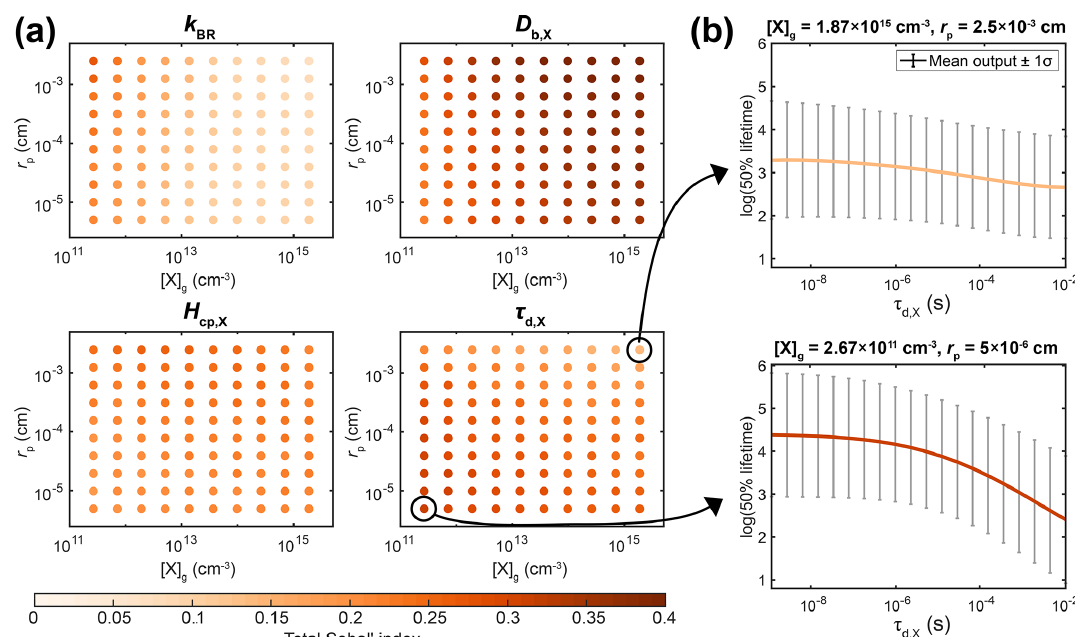
Figure 5. Detailed sensitivity analysis with the PCE method as a function of experimental conditions, i.e., the gas-phase concentration of X ([X] g,0 ) and particle radius ( r p ). (a) Total Sobol’ indices of four KM input parameters: bulk reaction rate coefficient of X and Y ( k BR ), bulk diffusion coefficient of X ( D b,X ), solubility coefficient of X ( H cp,X ), and desorption lifetime of X ( τ d,X ). (b) Relationship between the value of τ d,X and the chemical half-life of Y for two selected experimental conditions.